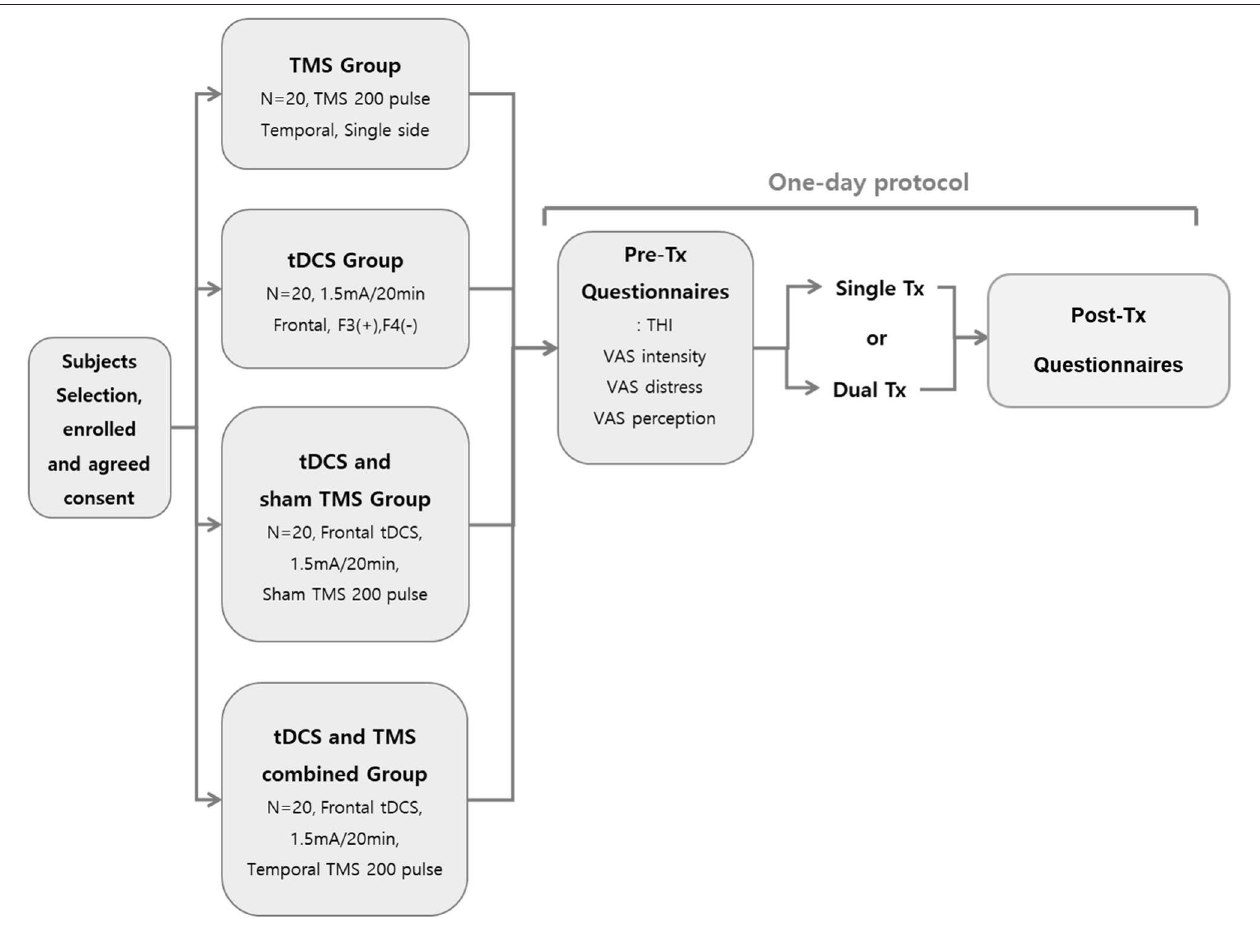
FIGURE 1 | Schematic summary of the study